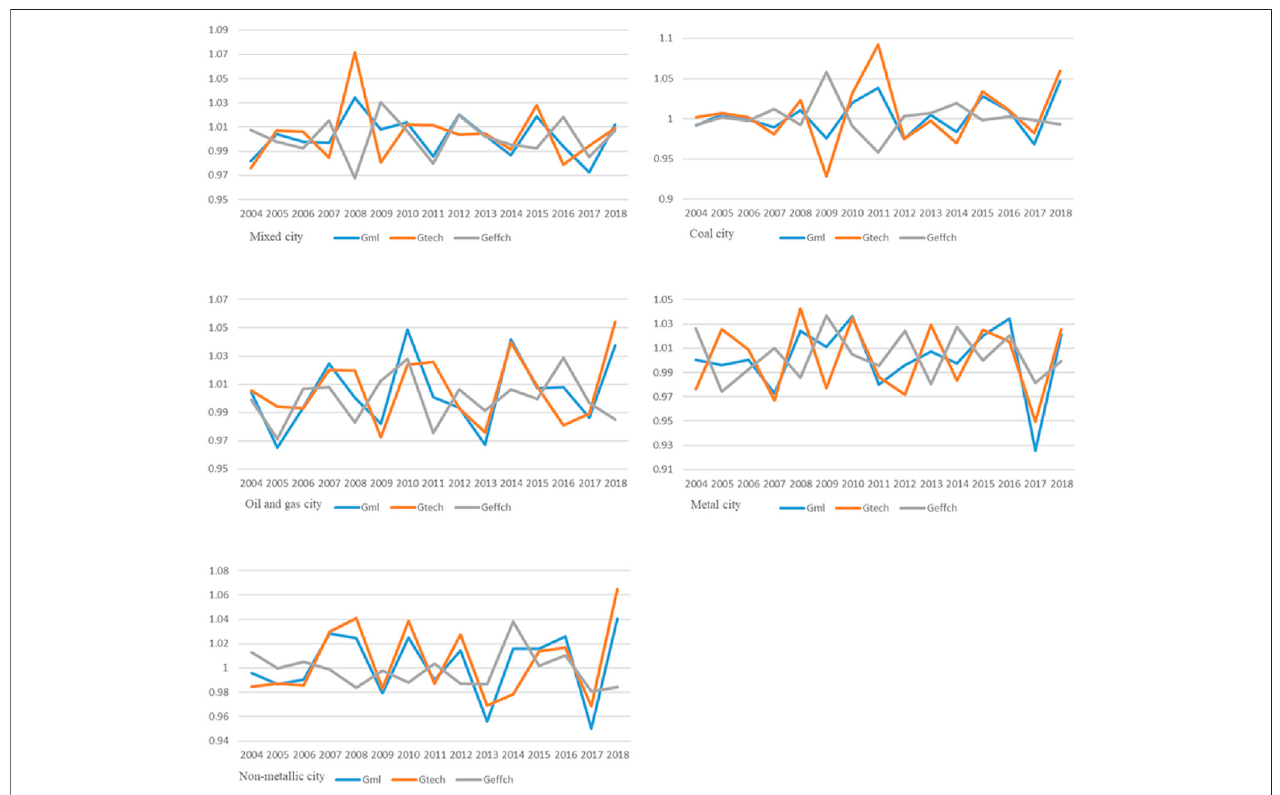
FIGURE 5 | The GML, Gtech, and Geffch indexes for fi ve resource-based cities with different resource properties from 2004 to 2018.